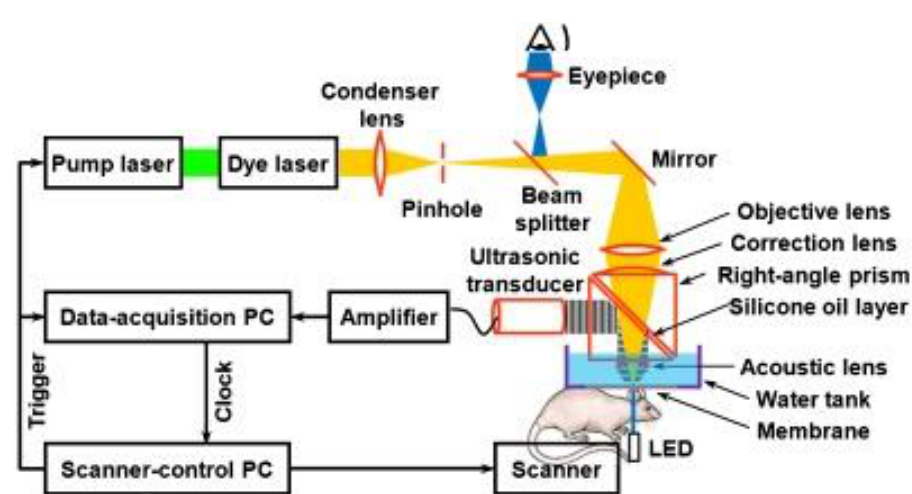
Figure 9. Schematic diagram of a photoacoustic microscope (taken with the permission of